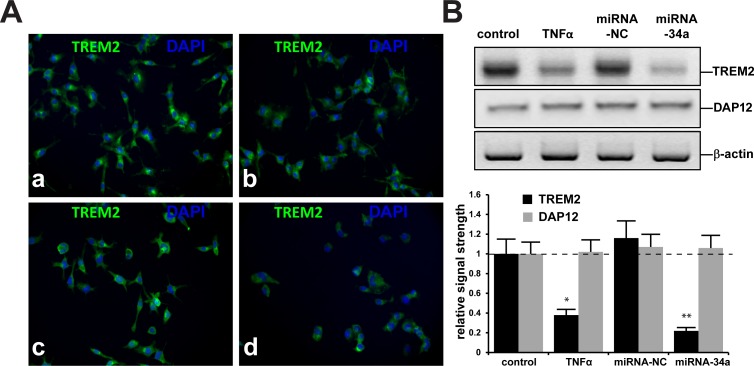
TREM2 and DAPI nuclear staining of C8B4 murine microglial (MG) cells (A): (a) control MG cells cultured 3 days, magnification 20x; (b) treated with TNFα; (c) treated with 50 nM miRNA-34a-sc (24 hr) or (d) treated with 50 nM miRNA-34a (24 hr); note significantly reduced TREM2 protein signals in stressed MG cells (b and d) compared to control (a) or miRNA-34a-sc-treated MG cells (C); Westerns blots were performed for TREM2 using an antibody directed against the 277 amino acid murine TREM2 (M227;sc-48765) or TYROBP (DAP12; C-20; sc-7853); SCBT, Santa Cruz, California, USA); nuclei stained with DAPI as in (Fig 6); (B) (upper panel) representative Western blot and (B) (lower panel) bar graph analysis of TREM2 and DAP12 protein levels in control, TNFα-, miRNA-NC or miRNA-34a-stressed MG cells; in this sample set TREM2 protein levels were found to be significantly reduced in TNFα- or miRNA-34a-treated MG cells compared to age matched controls; there were no significant differences in the abundance of the TYROBP/DAP12 adaptor protein amongst control, TNFα, miRNA-NC or miRNA-34a treated cells (Fig 7); N = 8; *p<0.05, **p<0.01 (ANOVA).